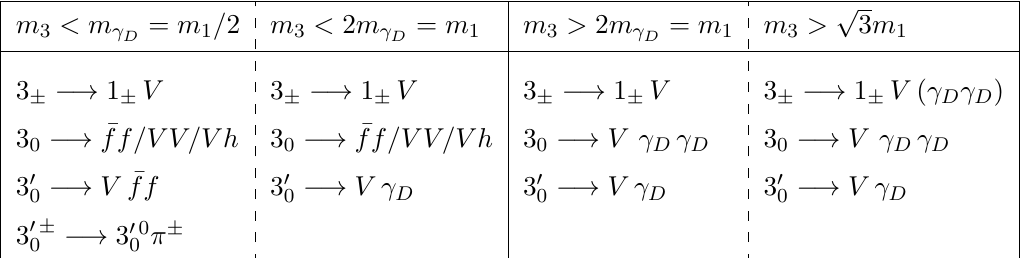
. Here D become important for ε small, when the 0